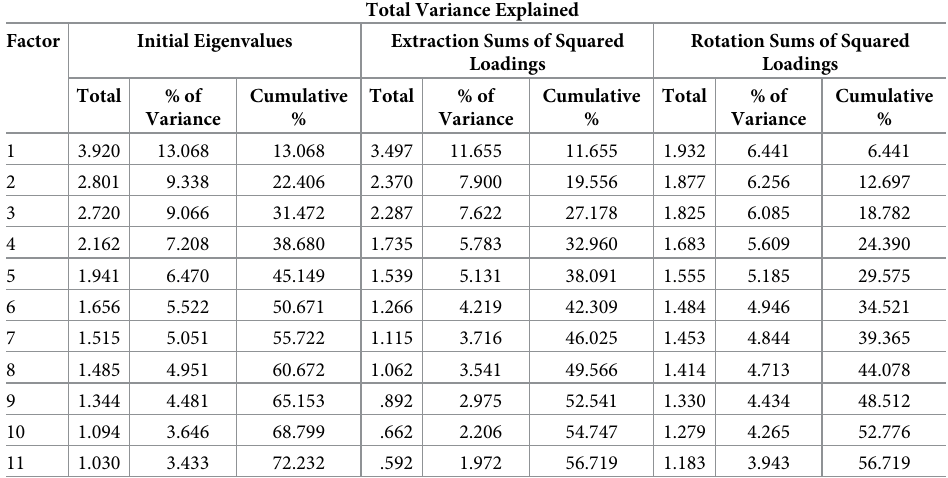
Table 3. The Eigenvalues and total variance explained by the extracted items among secondary school students, Jimma, Oromia, Ethiopia, 2021 (n = 576).